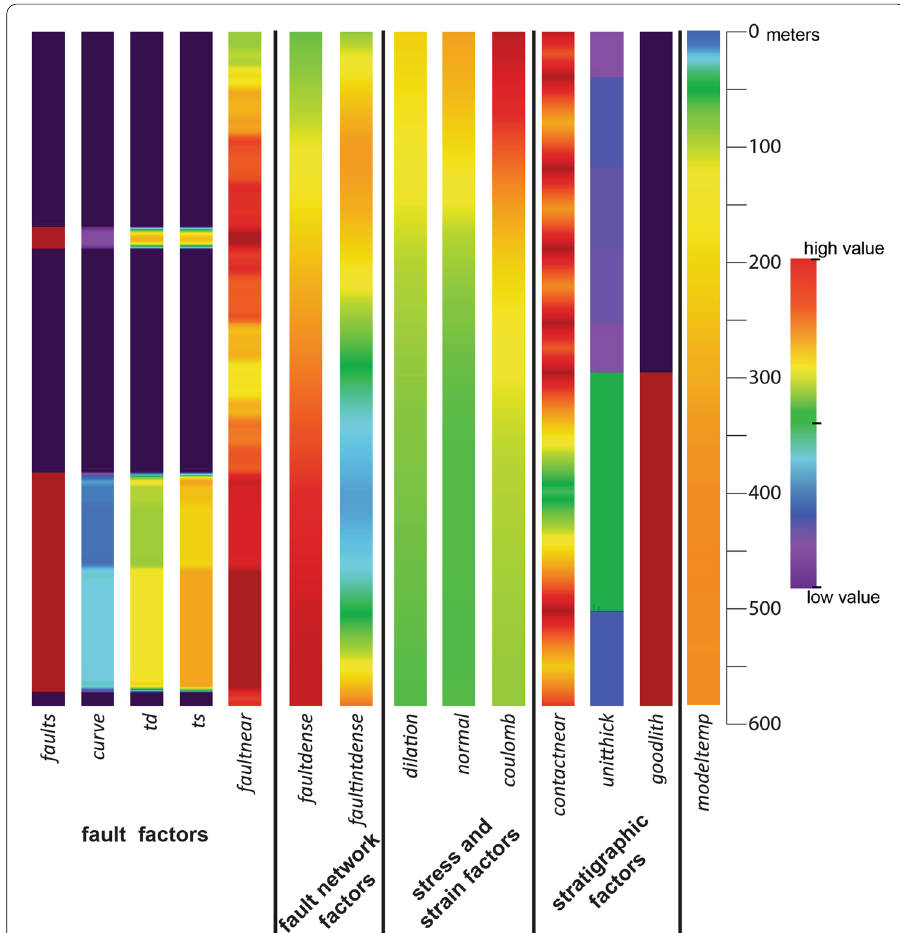
Fig. 2 The 14 variables used in this study along one of the Brady production wells. These are the input data for the NMFk algorithm. Cool colors correspond to low values and warm colors correspond to high values for each variable. For the binary variables (fault and goodlith), red corresponds to a value of one (a fault or the producing lithology), purple corresponds to a value of zero. For faultnear and contactnear warm colors indicate nearness to faults or